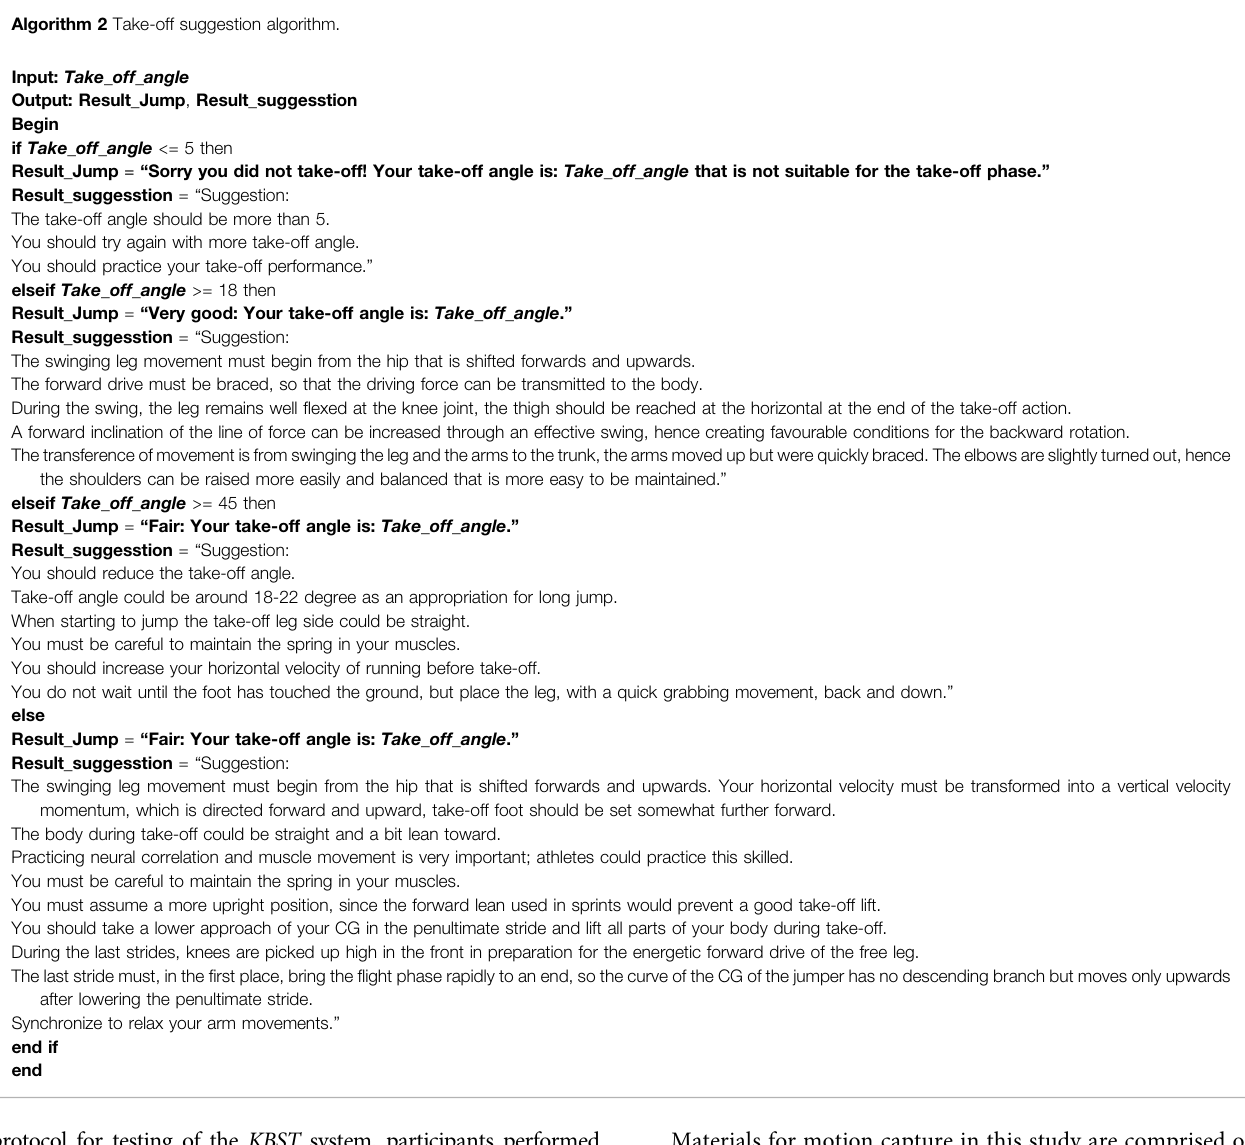
Algorithm 2 Take-off suggestion